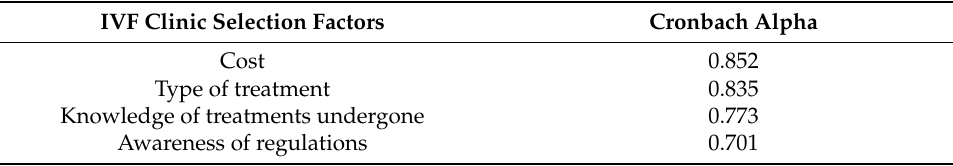
Table 3. Reliability test of clinic selection factors (Minitab Software).